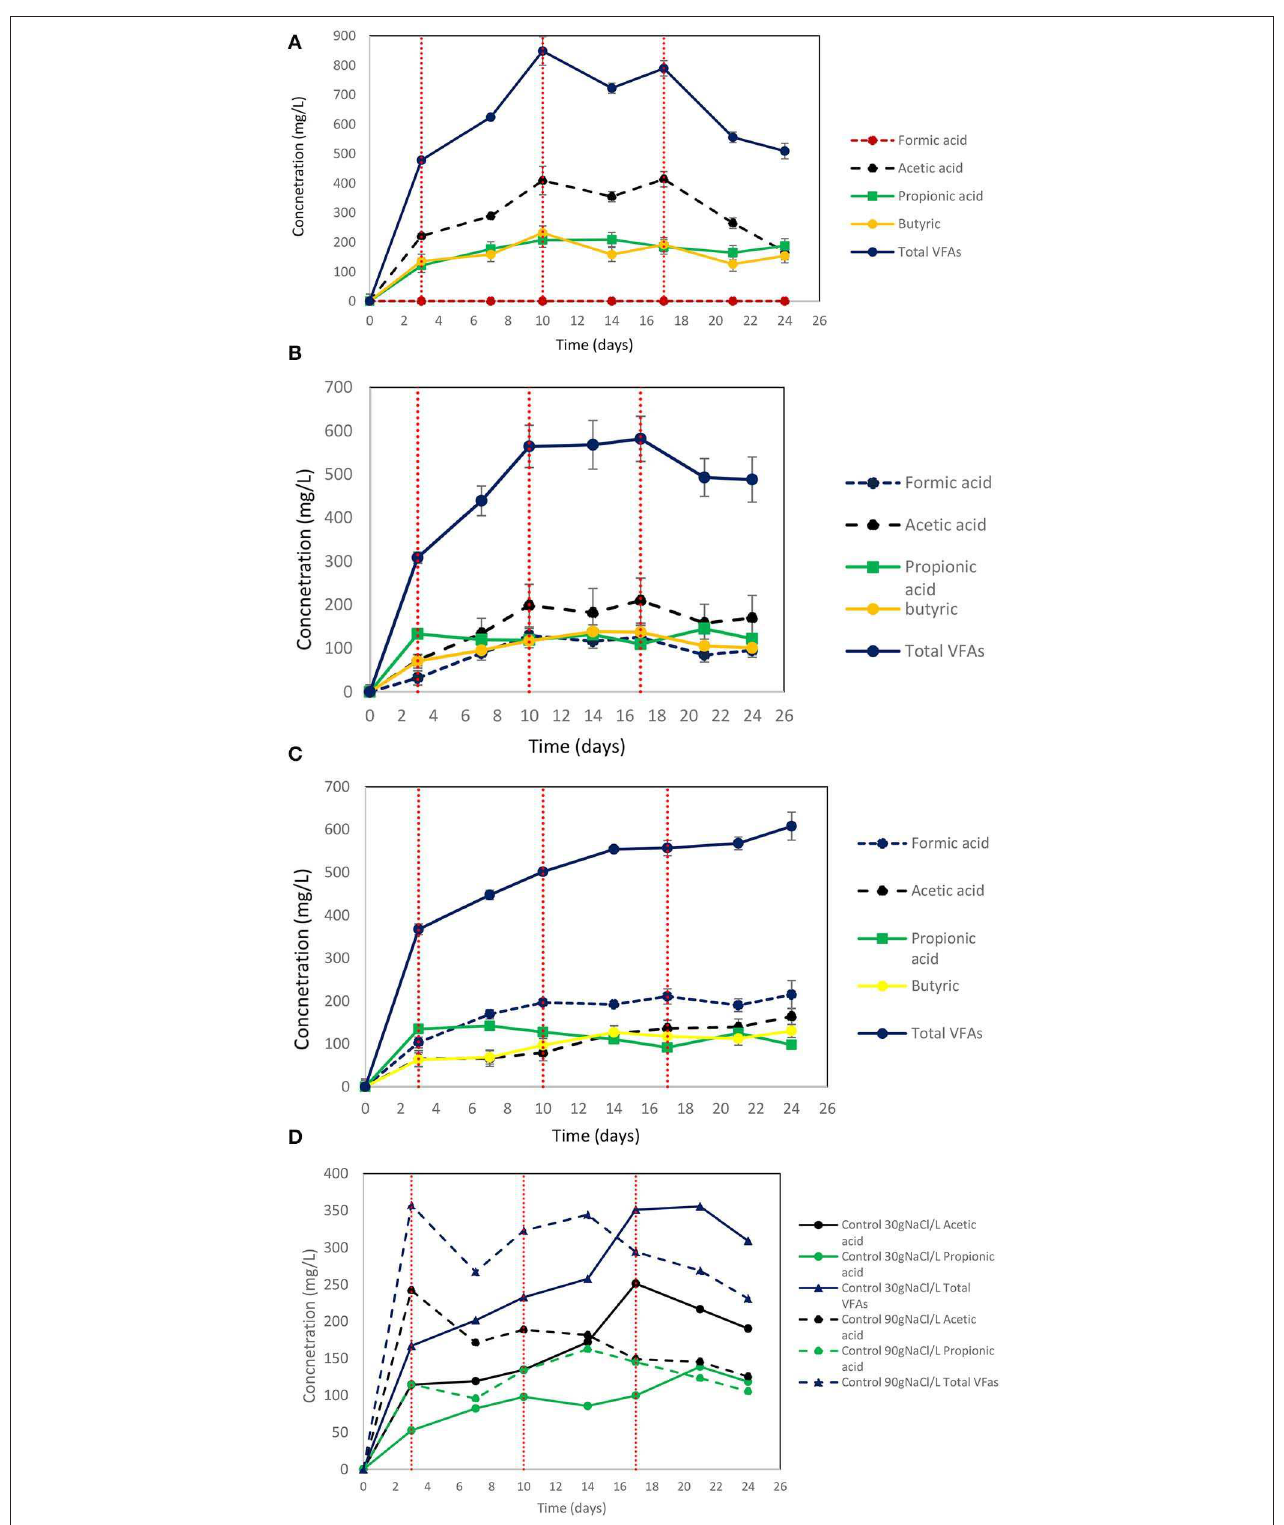
FIGURE 9 | (A) Production of VFAs by anaerobic granular sludge exposed to 30g NaCl/L, 100g ZVI/L and CO 2 as a sole carbon source. CO 2 re flushing took place on days 3, 10, and 17. (B) Production of VFAs by anaerobic granular sludge exposed to 60g NaCl/L, 100g ZVI/L and CO 2 as a sole carbon source. CO 2 re flushing took place on days 3, 10, and 17. (C) Production of VFAs by anaerobic granular sludge exposed to 90g NaCl/L, 100g ZVI/L and CO 2 as a sole carbon source. CO 2 re flushing took place on days 3, 10, and 17. (D) Production of VFAs by control anaerobic granular sludge exposed to 30 and 90g NaCl/L and CO 2 as a sole carbon source. No ZVI were added to controls. CO 2 re flushing took place on days 3,10, and 17.